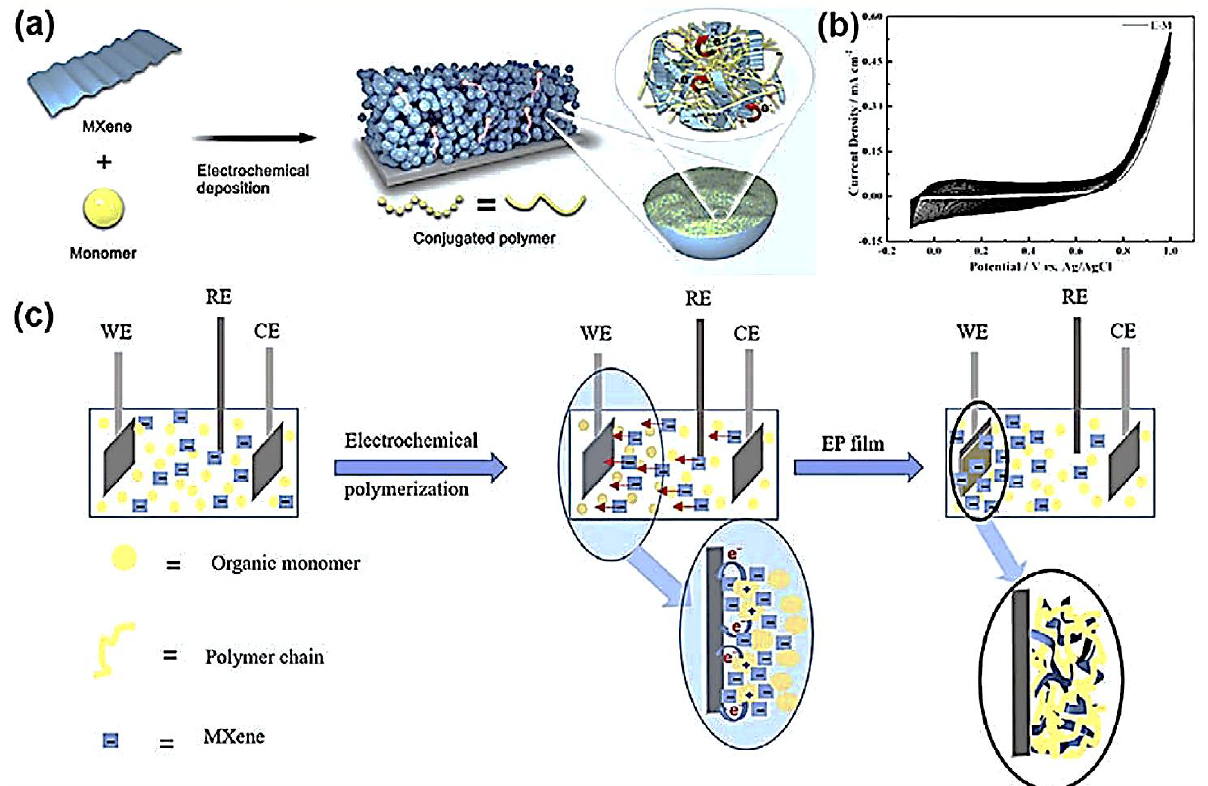
Figure 15. ( a ) The electrochemical polymerization of conjugated polymer-MXene composite. ( b ) Cyclic voltammogram of ( a ) V with the scan rate of 50 mV s −1 . ( c ) MXene ‐ facilitated electrochemical polymerization for flexible solid ‐ state microsupercapacitors. Reprinted with permission from Reference [189] @ 2019 Elsevier Ltd.